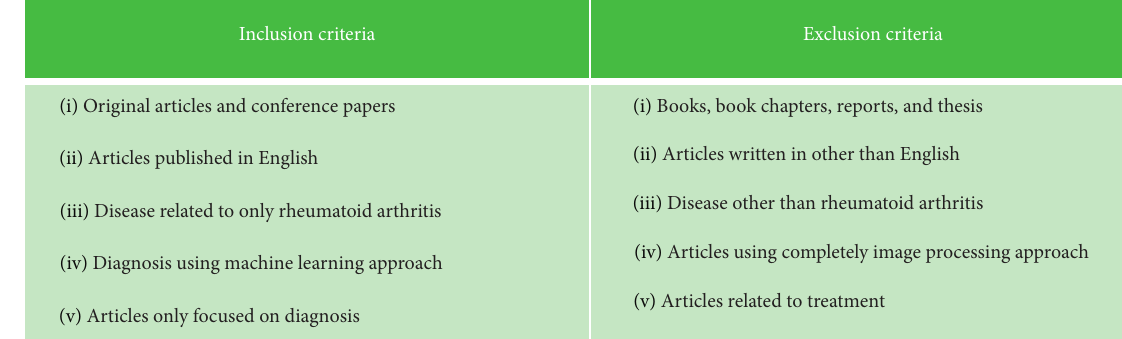
Figure 1: Inclusion and exclusion criteria for selecting papers.